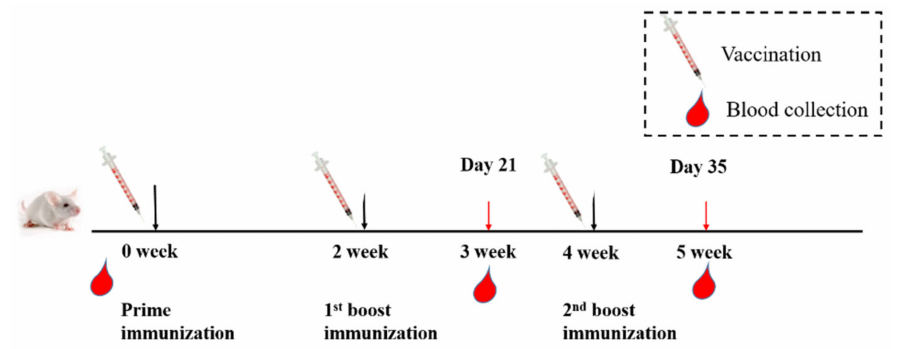
Figure 1. Schematic diagram of immunization strategy and sample collection. Twelve groups of mice (five mice/group) were intramuscularly immunized with RBD-Fc, RBD and S-trimer plus PBS, alum, MF59 or nanoparticle manganese adjuvant, respectively, three times at two-week intervals. Sera were collected one week after each immunization for antibody detection and viral load reduction